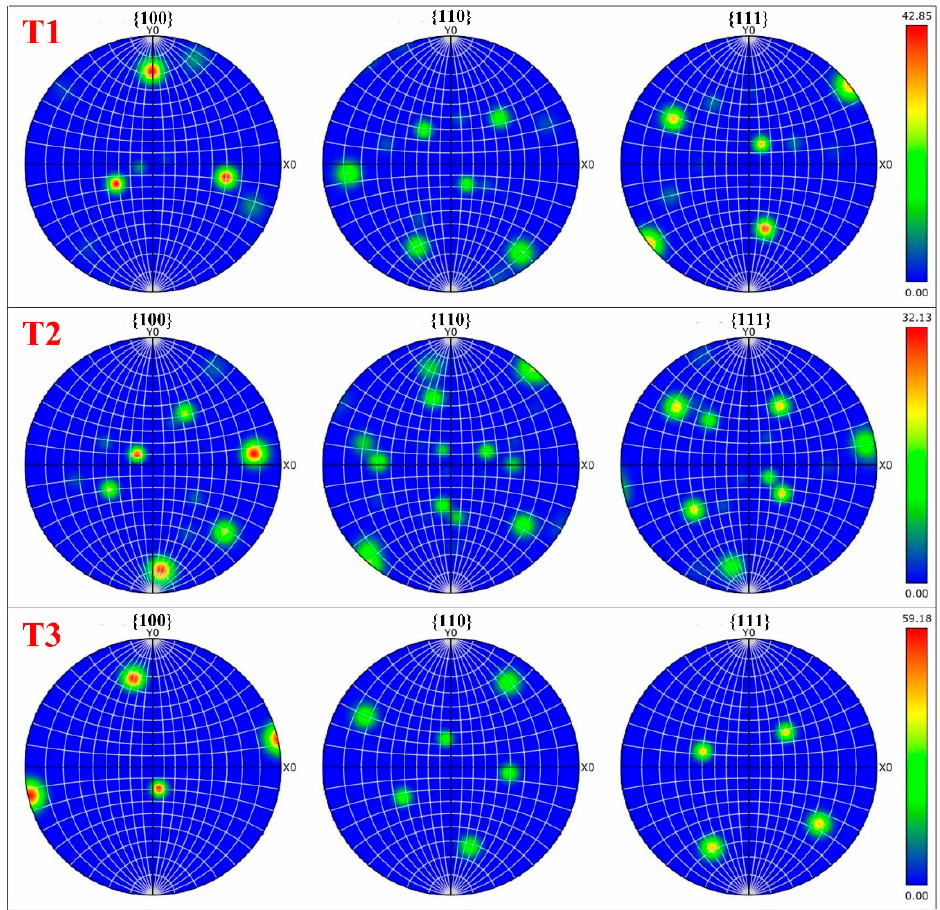
Figure 3. Pole figure maps of SLM Ti ‐ 6Al ‐ 4V materials